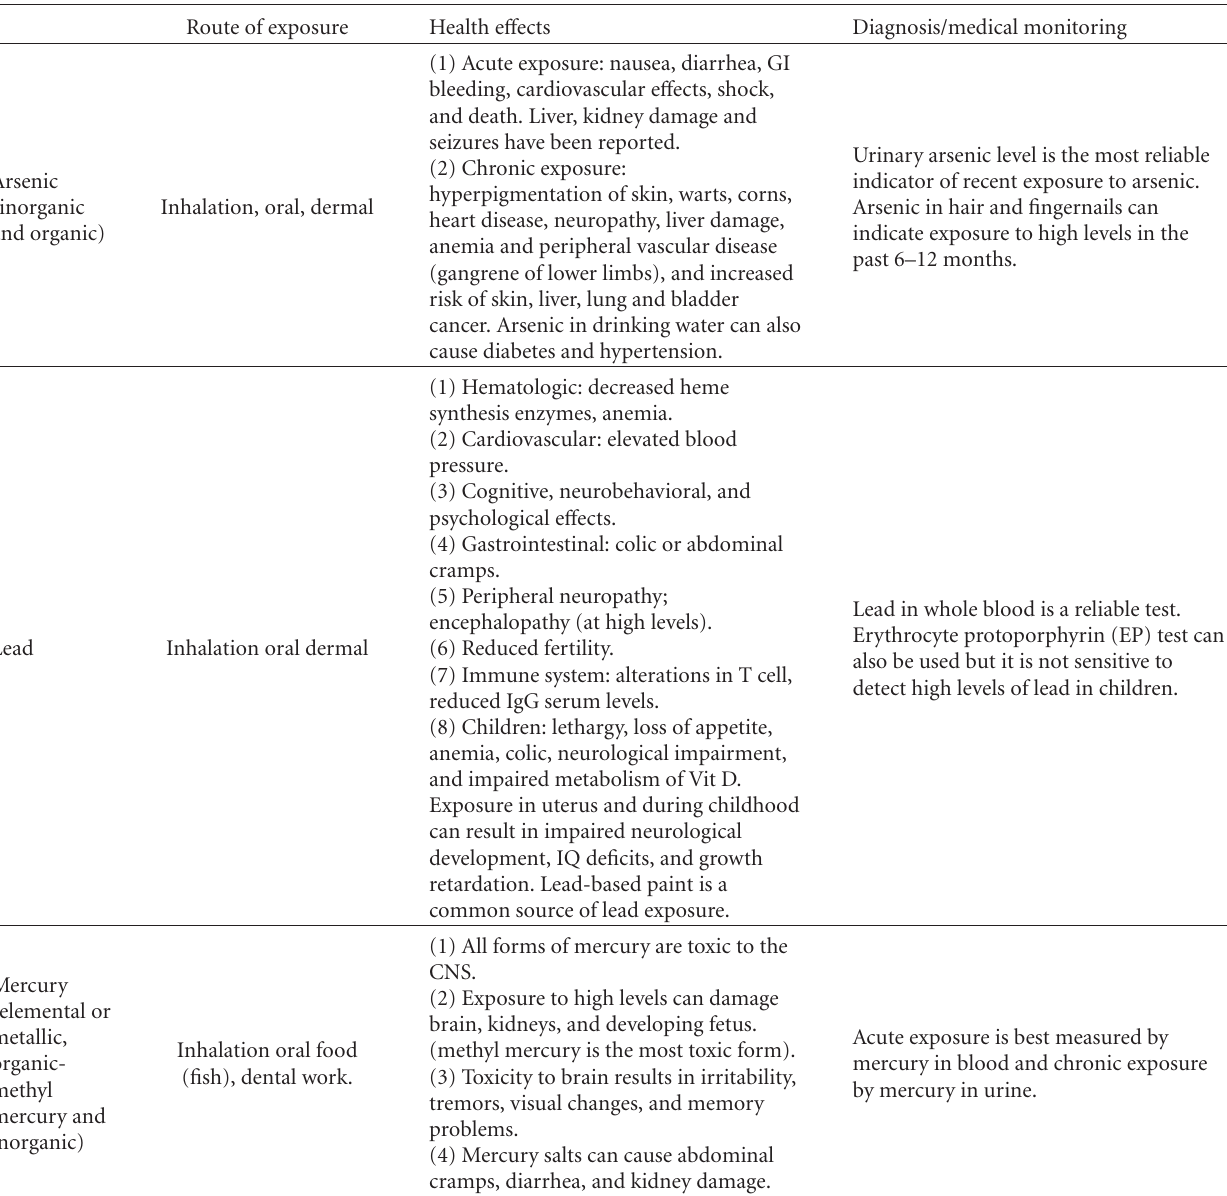
Table 2: Routes of exposure, health e ff ects, and diagnosis/medical monitoring for arsenic, lead, and